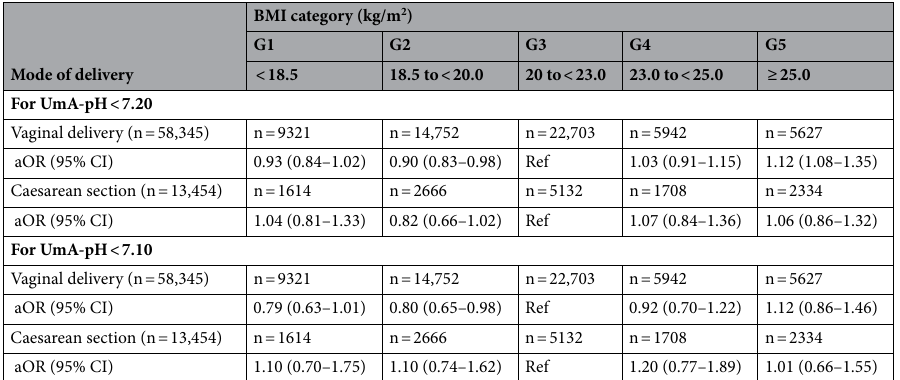
Table 3. aORs and 95% CIs for intrapartum foetal acidosis by pre-pregnancy BMI after stratification based on mode of delivery. Logistic regression models were used to calculate the adjusted odds ratios and 95% CIs for UmA-pH < 7.20 and < 7.10, using G3 as the reference group. aOR, adjusted odds ratio; BMI, body mass index; CI, confidence interval; Ref., reference; UmA-pH, umbilical artery pH. Model adjusted for maternal